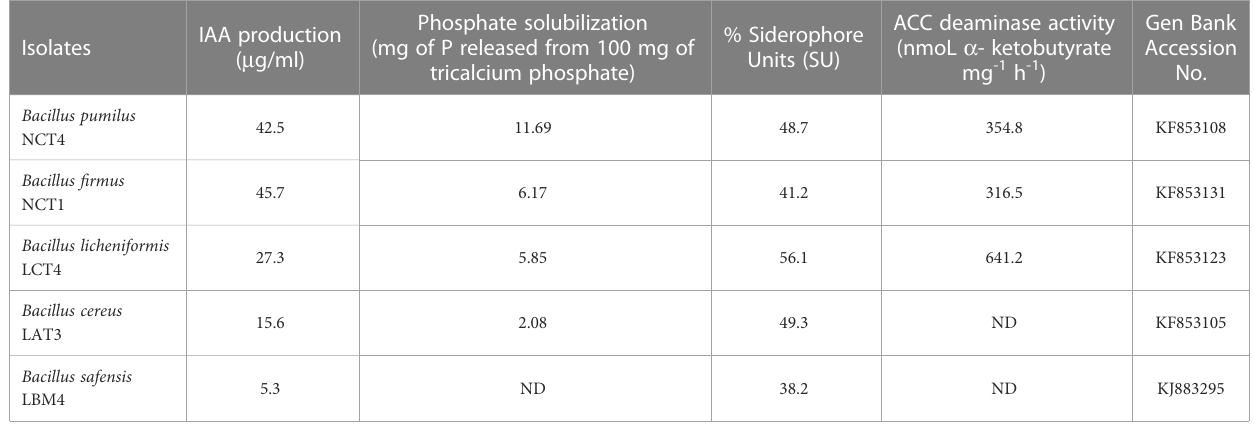
TABLE 1 Plant growth-promoting rhizobacteria (PGPR) traits of the selected isolates.